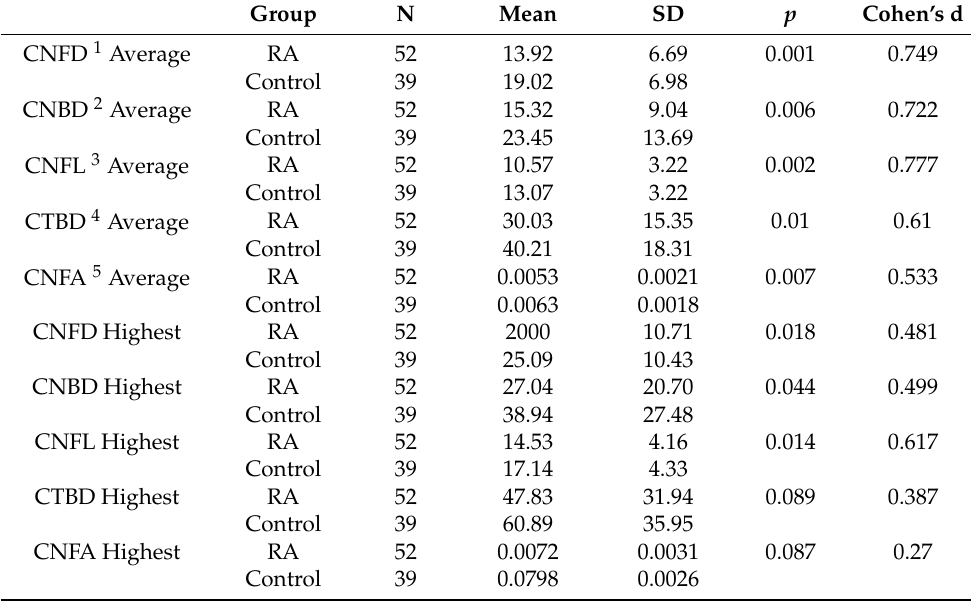
Table 2. Mean and SD values for the CNFD–CNBD–CNFL–CTBD–CNFA variables of the RA and control samples, with p values and Cohen’s d values of the